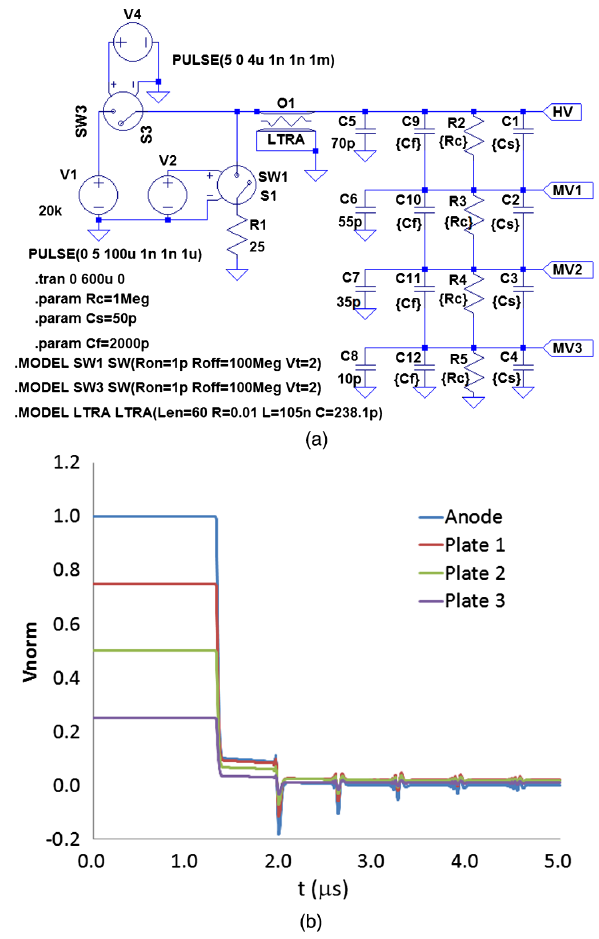
FIG. 13. (a) Equivalent circuit of the ES-Kicker system giving the long tail at the falling edge. (b) Simulation result of the voltage pulse around the falling edge. Here, the voltage is normalized by the anode voltage at the flattop.